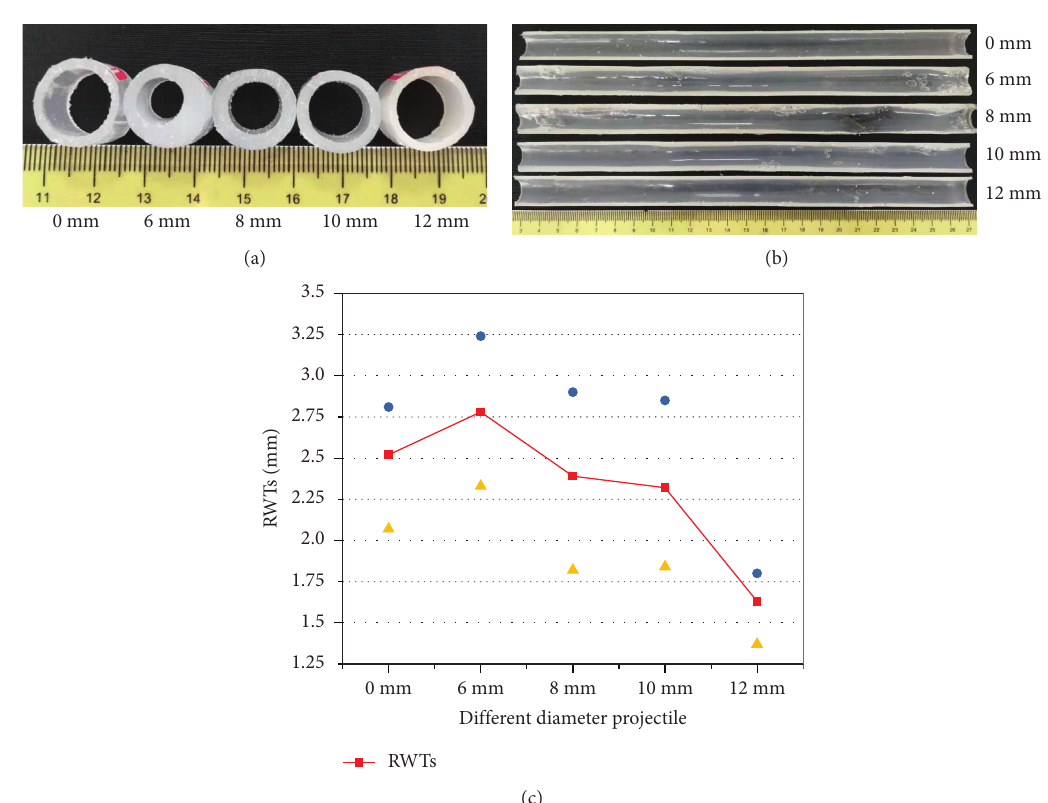
Figure 5: Comparison of RWTs between WAIM and different diameters projectile W-PAIM pipe: (a) transverse section of WIAM and W-PAIM pipes, (b) longitudinal section of WIAM and W-PAIM pipes, and (c) RWTs and error bar.